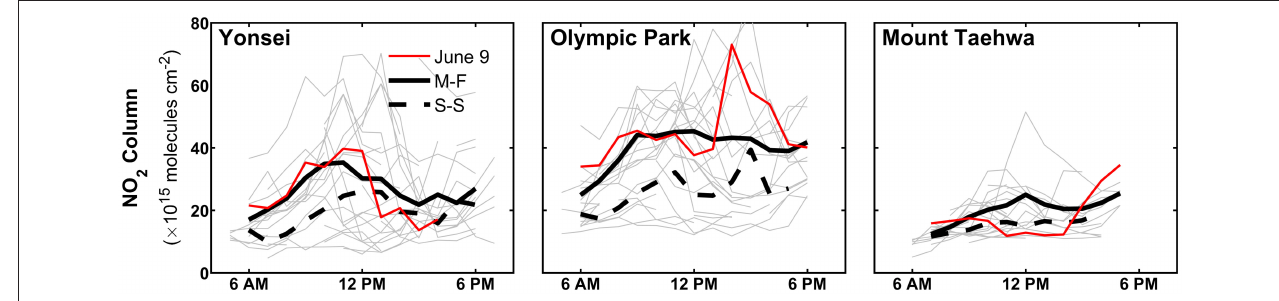
FIGURE 6 | Hourly averaged NO 2 vertical columns observed by ground-based Pandora spectrometers at Yonsei University, Olympic Park, and Mount Taehwa. Gray lines are the individual day diurnal averages from May 5th through June 15th, 2016. June 9th, 2016 is overlaid in red, the weekday (Monday–Friday) averages are the black solid lines, and weekend (Saturday–Sunday) average observations are the black dashed